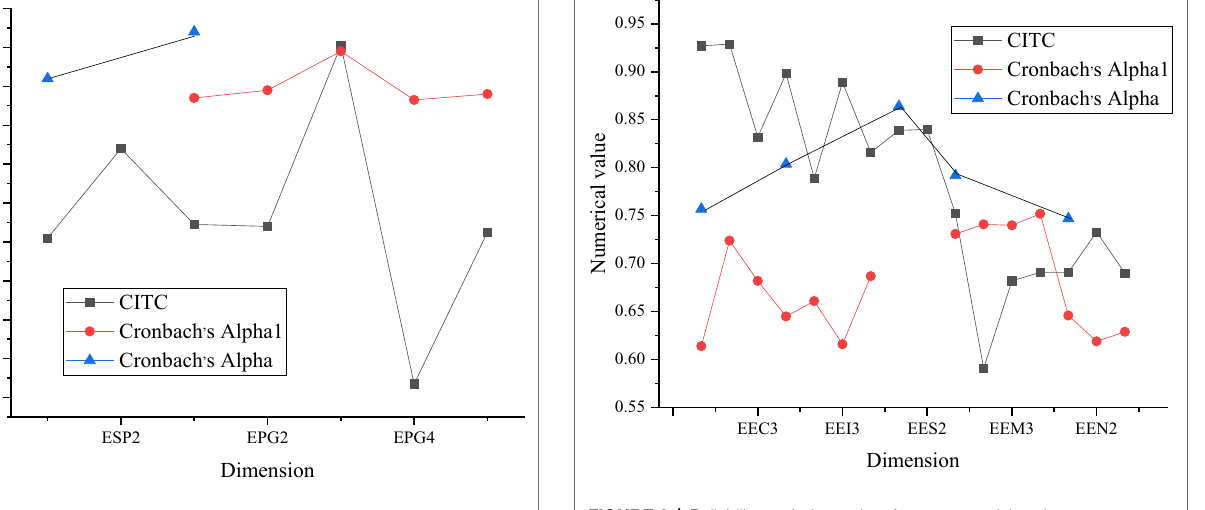
Figure 12 indicates multiple comparisons of psychological capital of new generation entrepreneurs with different establishment times.